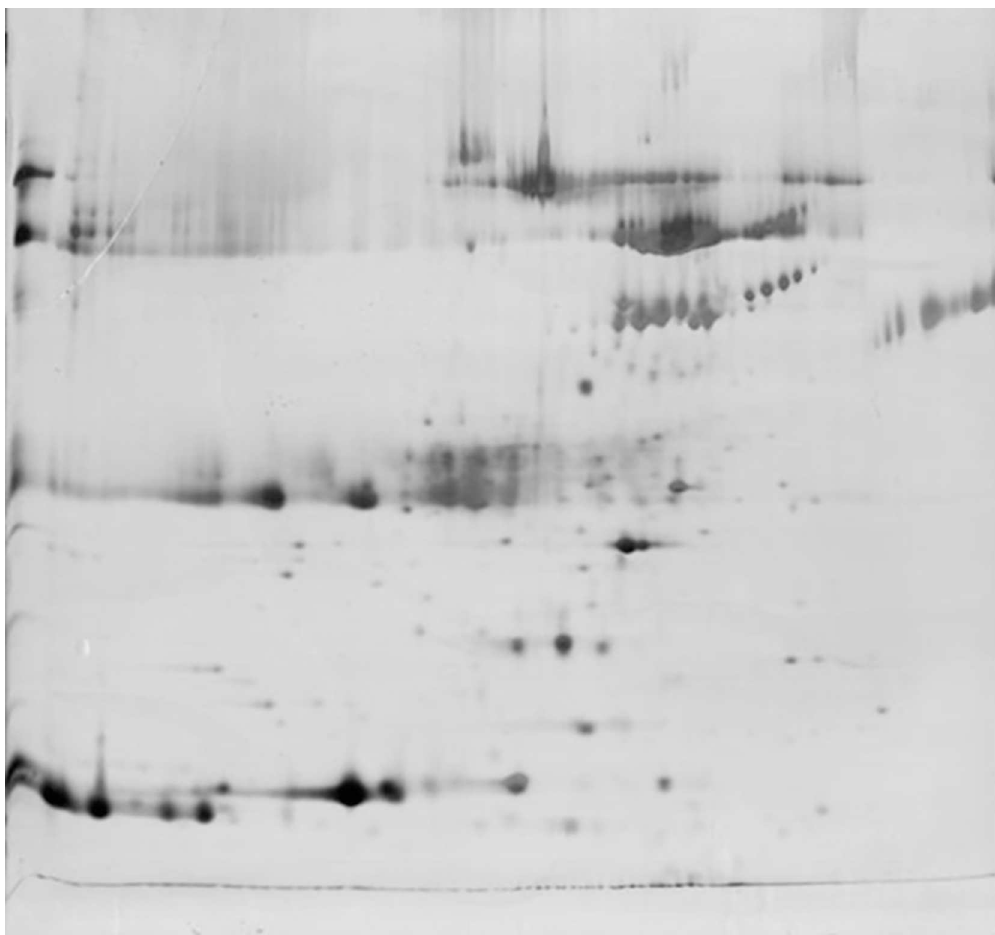
Fig 1. Protein spots of kidney preservation solution identified by 2D gel